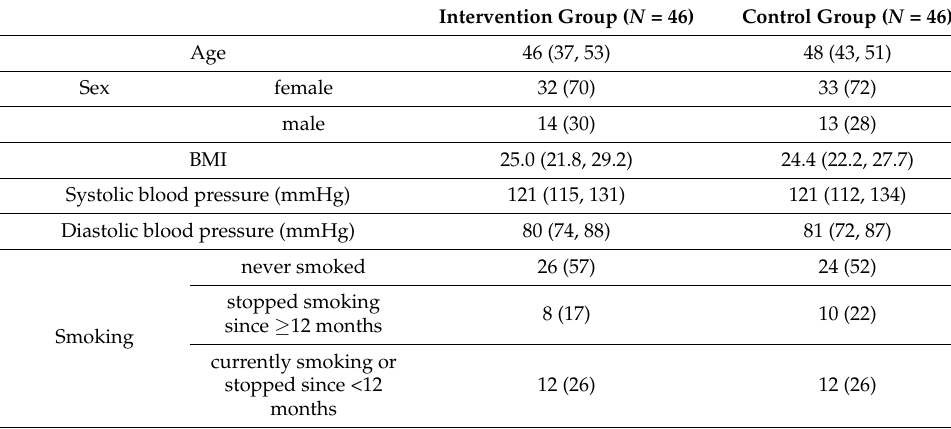
Figure 1. CONSORT participant flow. Table 1. Baseline characteristics.